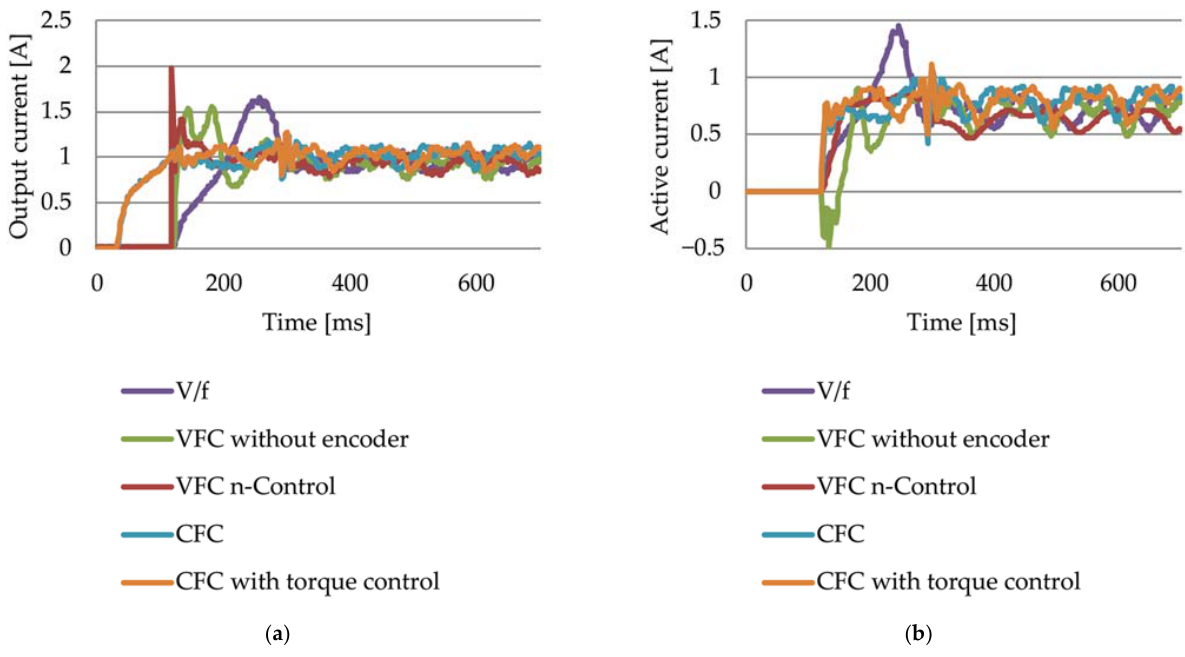
Figure 8. Comparison of: ( a ) output current intensity values (I O ) for various control modes, ( b ) active current intensity values (I A ) for various control modes.